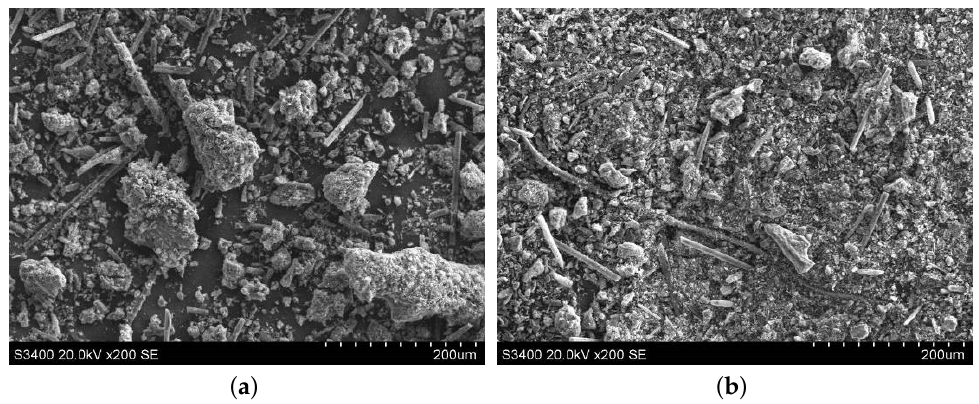
Figure 20. Morphologies comparison when a p is 0.5 mm. ( a ) is ordinary cutting and ( b ) is ultrasound- assisted